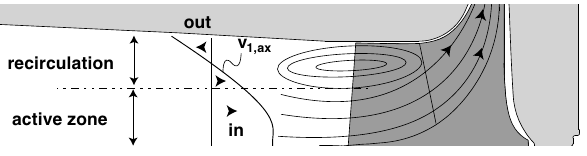
Figure 9. Definition of active and recirculation zone in the inducer.